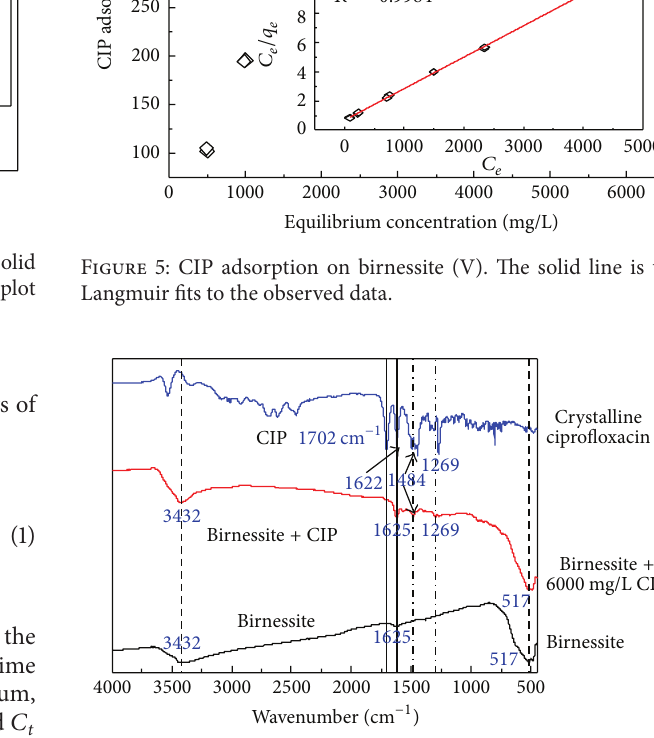
Figure 6: FTIR spectra of CIP (6000mg/L) adsorbed birnessite (V) at 450–4000 cm −1